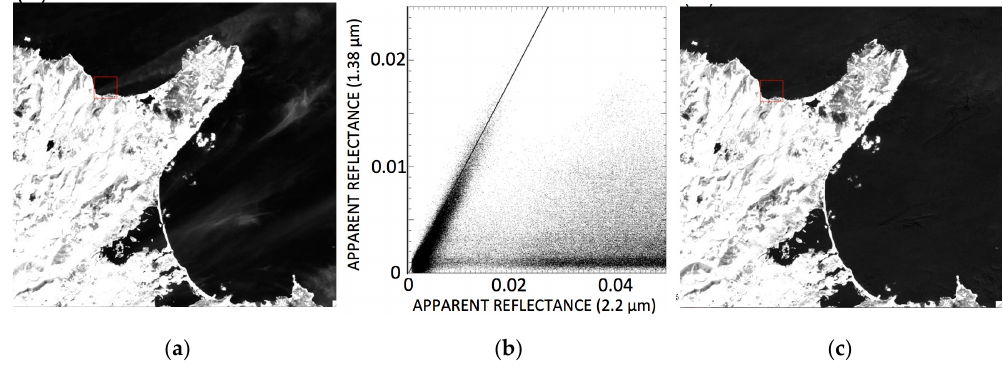
Figure 5. ( a ) A Landsat 8 OLI SWIR1 image acquired over Cape Breton Island in eastern Canada (northeast to Halifax) on 16 September 2014; ( b ) The scatter plot of Band 9 (cirrus) versus SWIR1 band; ( c ) The cirrus-corrected SWIR1 image.